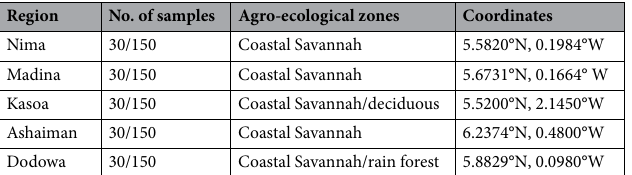
Table 1. Geographical locations and some attributes of the origin of brukina samples obtained from Greater Accra region of